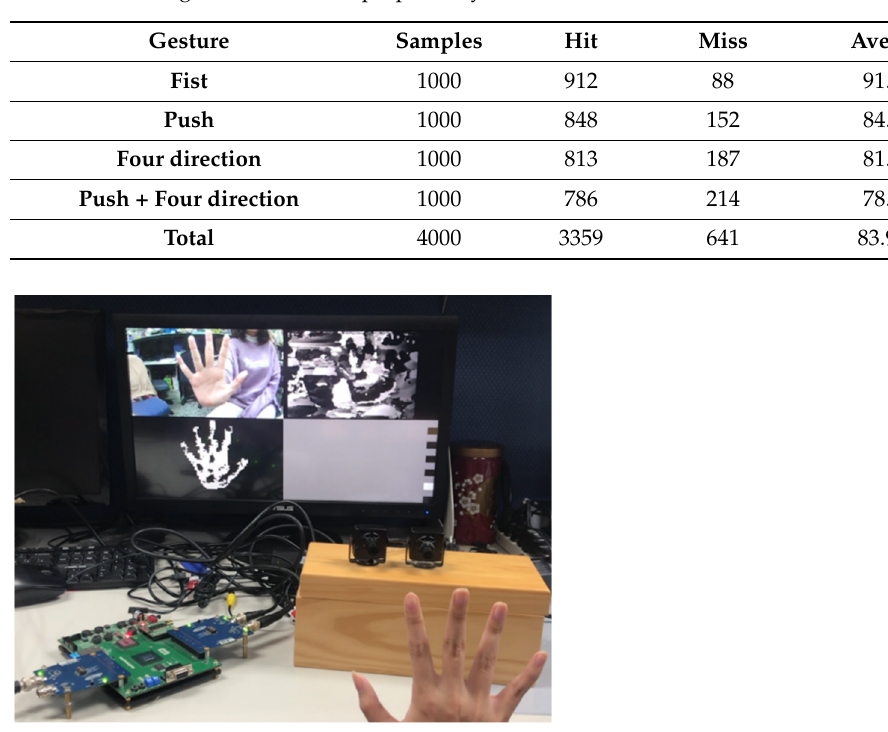
Figure 15. The real demonstration system.